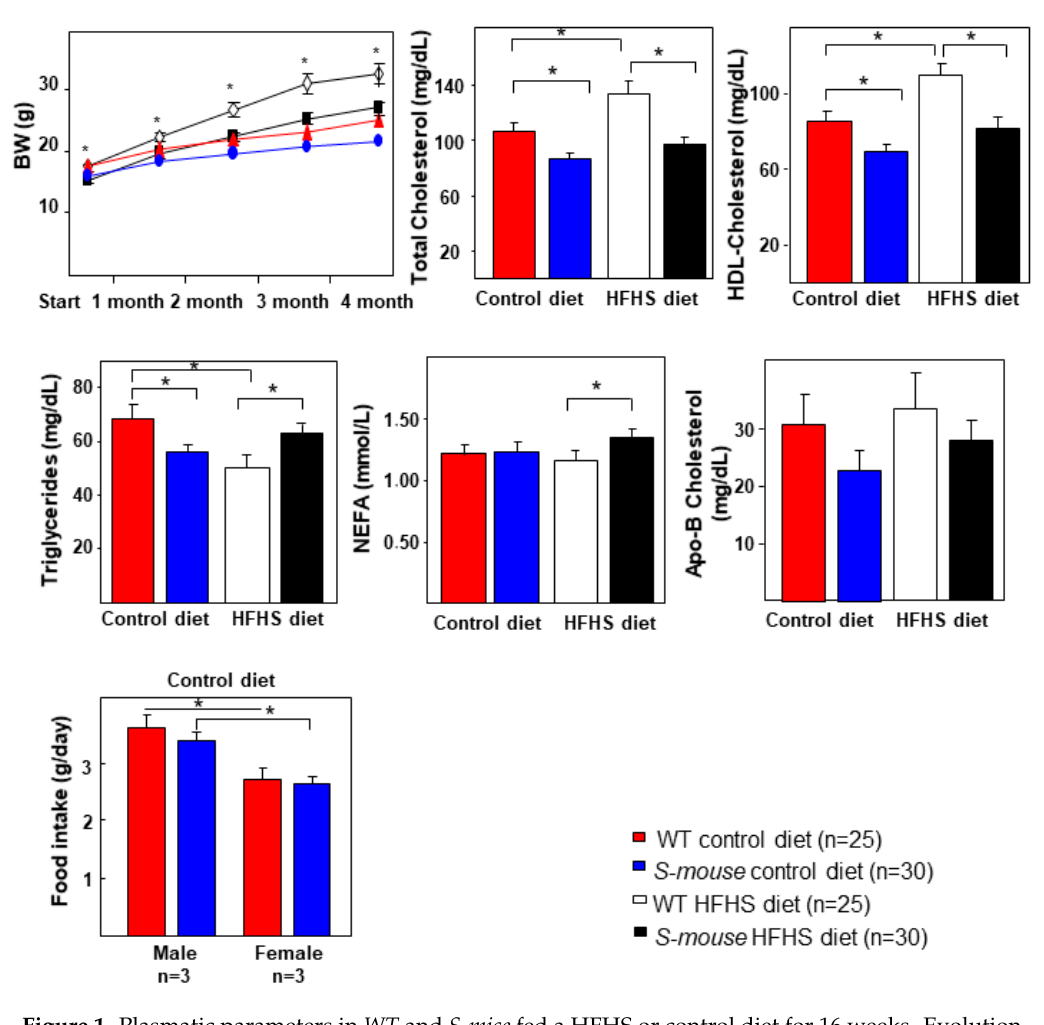
Figure 1. Plasmatic parameters in WT and S-mice fed a HFHS or control diet for 16 weeks. Evolution of body weight and total cholesterol, HDL-cholesterol, TG, NEFAs and apoB-cholesterol in fasted overnight levels in all mice groups. Data are presented as mean ± SEM. Statistical analysis was performed using one-way ANOVA. * p ≤ 0.05 . HFHS high-fat, high-sucrose, BW body weight, NEFAS non-esterified fatty acid, HDL high-density lipoprotein, WT Wild type, TG